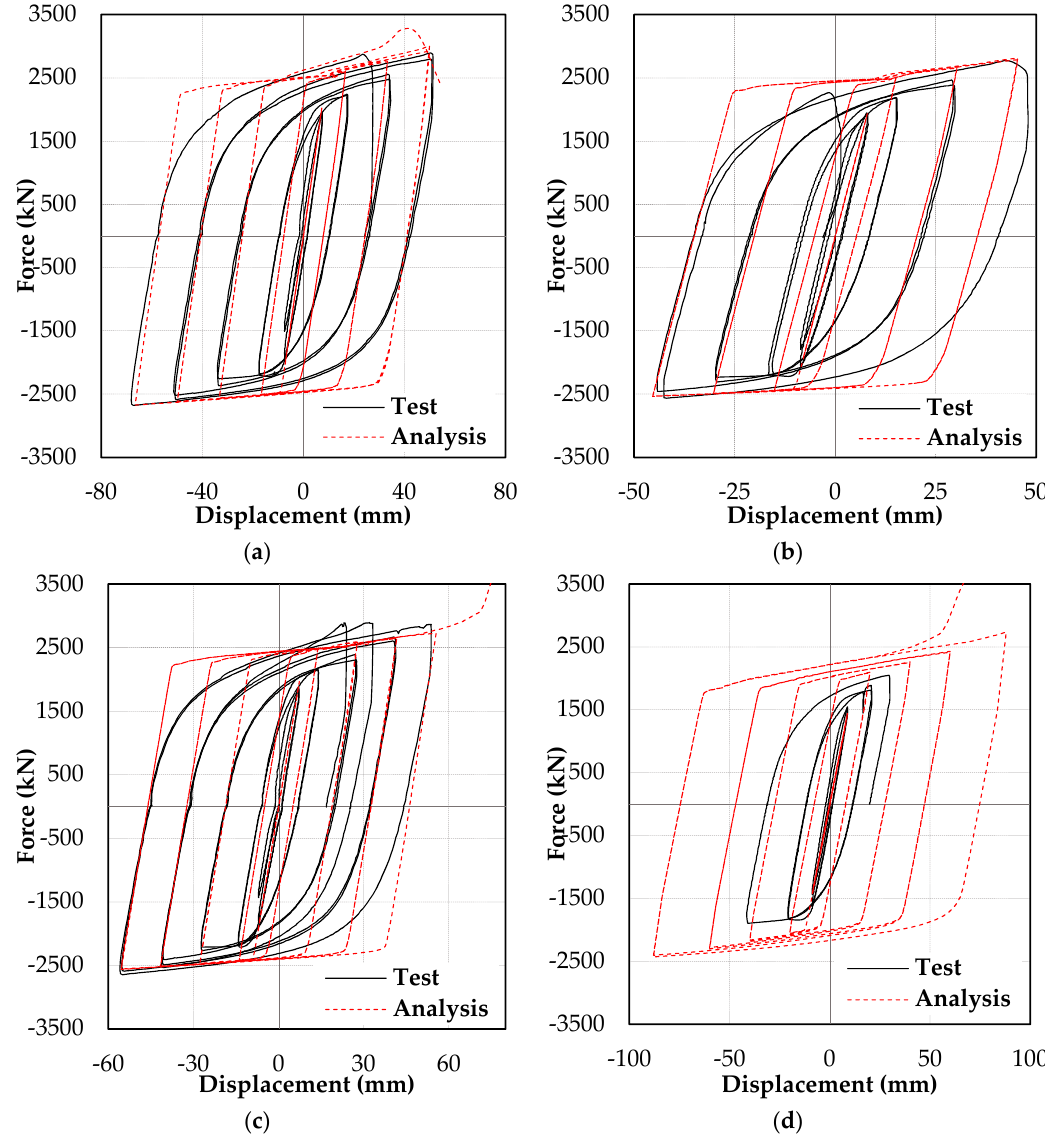
Figure 9. Comparison of test and finite element analysis results. Specimens ( a ) 1, ( b ) 2, ( c ) 3, and ( d ) 4.